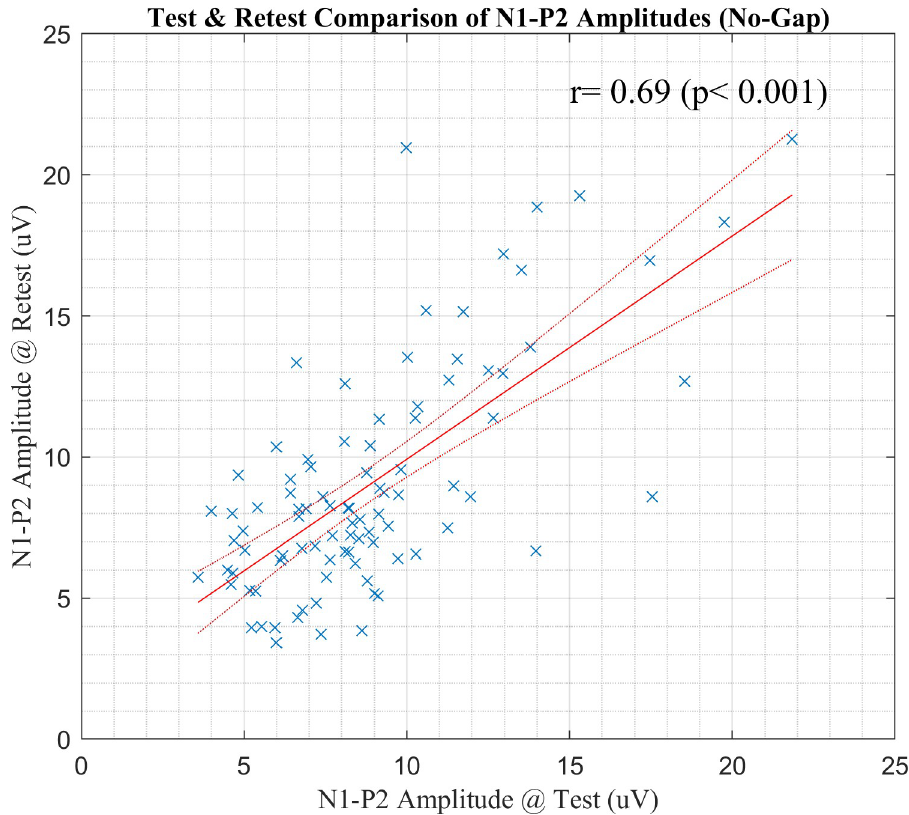
Fig 8. A scatter plot of the N1-P2 amplitudes between test and retest sessions. The red solid and dotted lines indicate the fitting line and 95% confidence intervals, respectively, based on linear regression analysis.